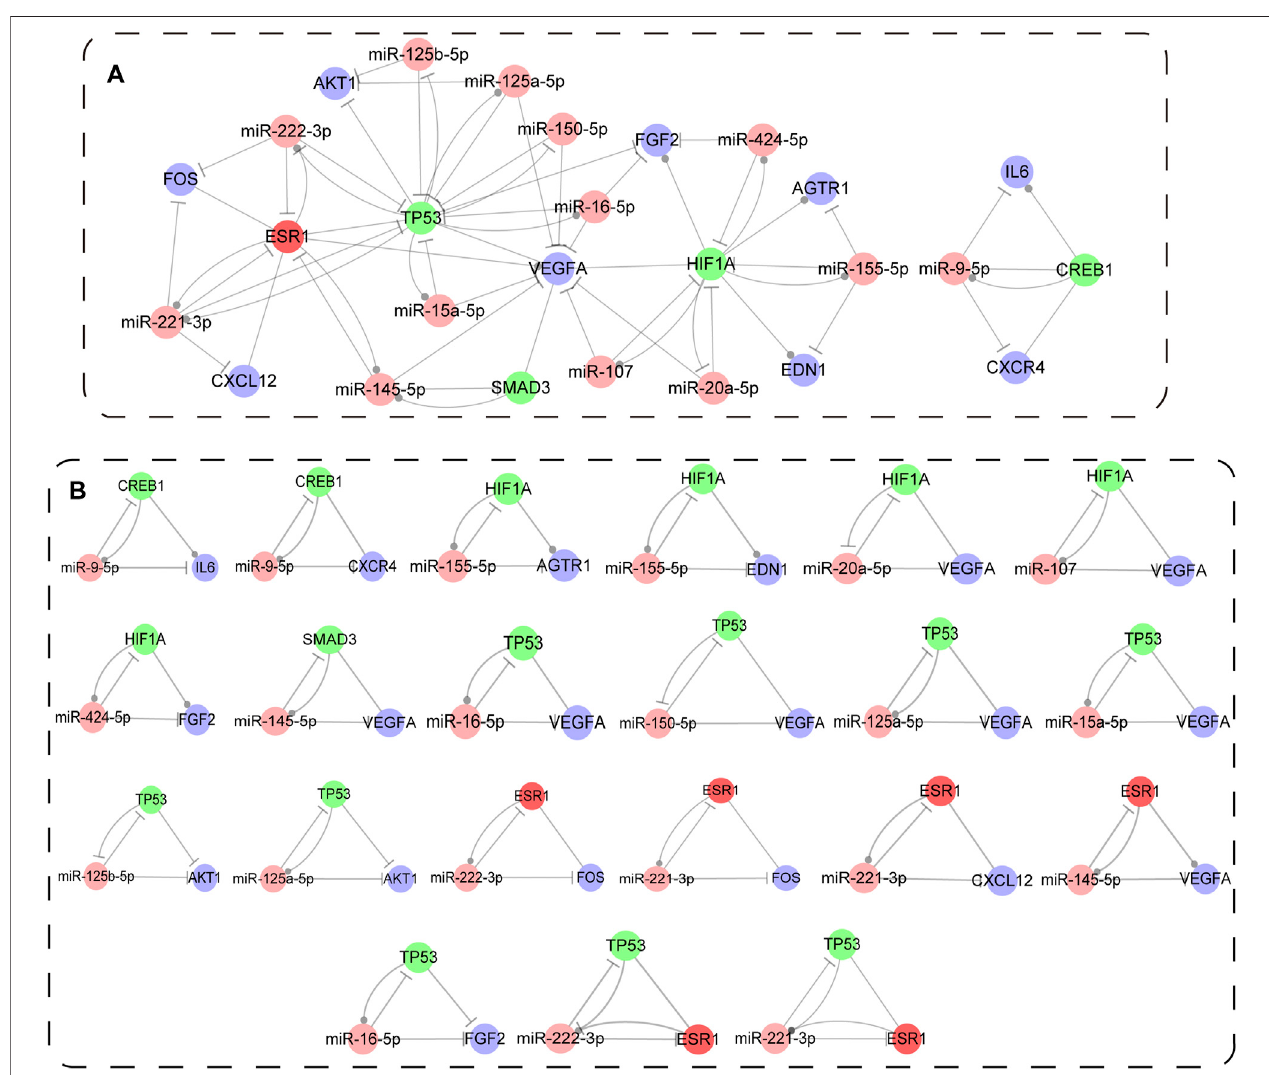
FIGURE 5 | Immune associated composite FFL motif-speci fi c sub-network (IA-CFMSN). (A) A global view of immune associated composite FFL motif-speci fi c sub-network (IA-CFMSN). Pink representsmiRNAs, TFs, genesand TF&gene were colored in pink, green, blue and red, respectively.A line ending in a circle represents the active relationship, while, a line ending in a “ T ” represents the repression relationship. (B) All 3-node composite FFLs extracted from IA-CFMSN.